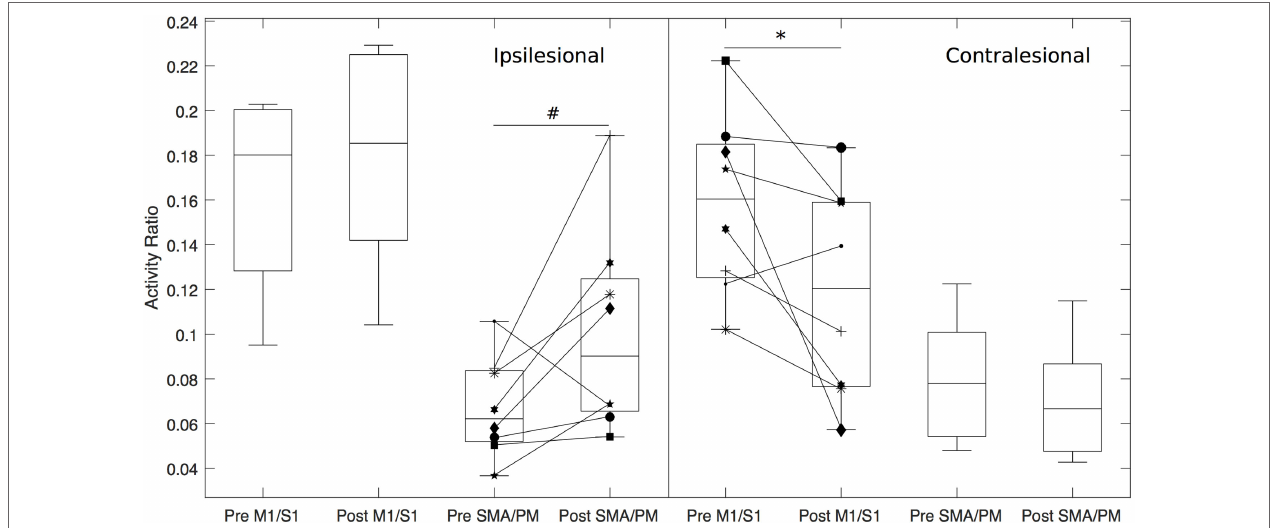
FigUre 4 | Box plots depicting cortical activity ratio prior to and following the intervention for hand opening on the table. Regions of interests include M1/S1 and supplementary motor area/premotor area (SMA/PM) for both ipsilesional (left side of figure) and contralesional (right side of figure) hemispheres. *indicates p < 0.05, # indicates p =